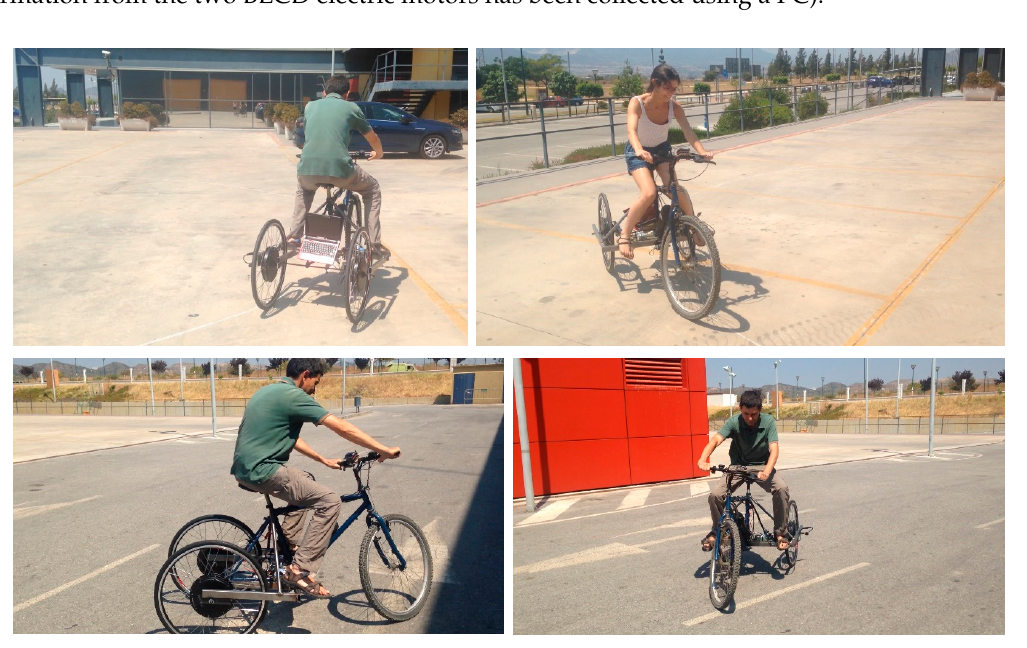
Figure 6. circuits designed and used: Top: circular path. Bottom: Slalom path.